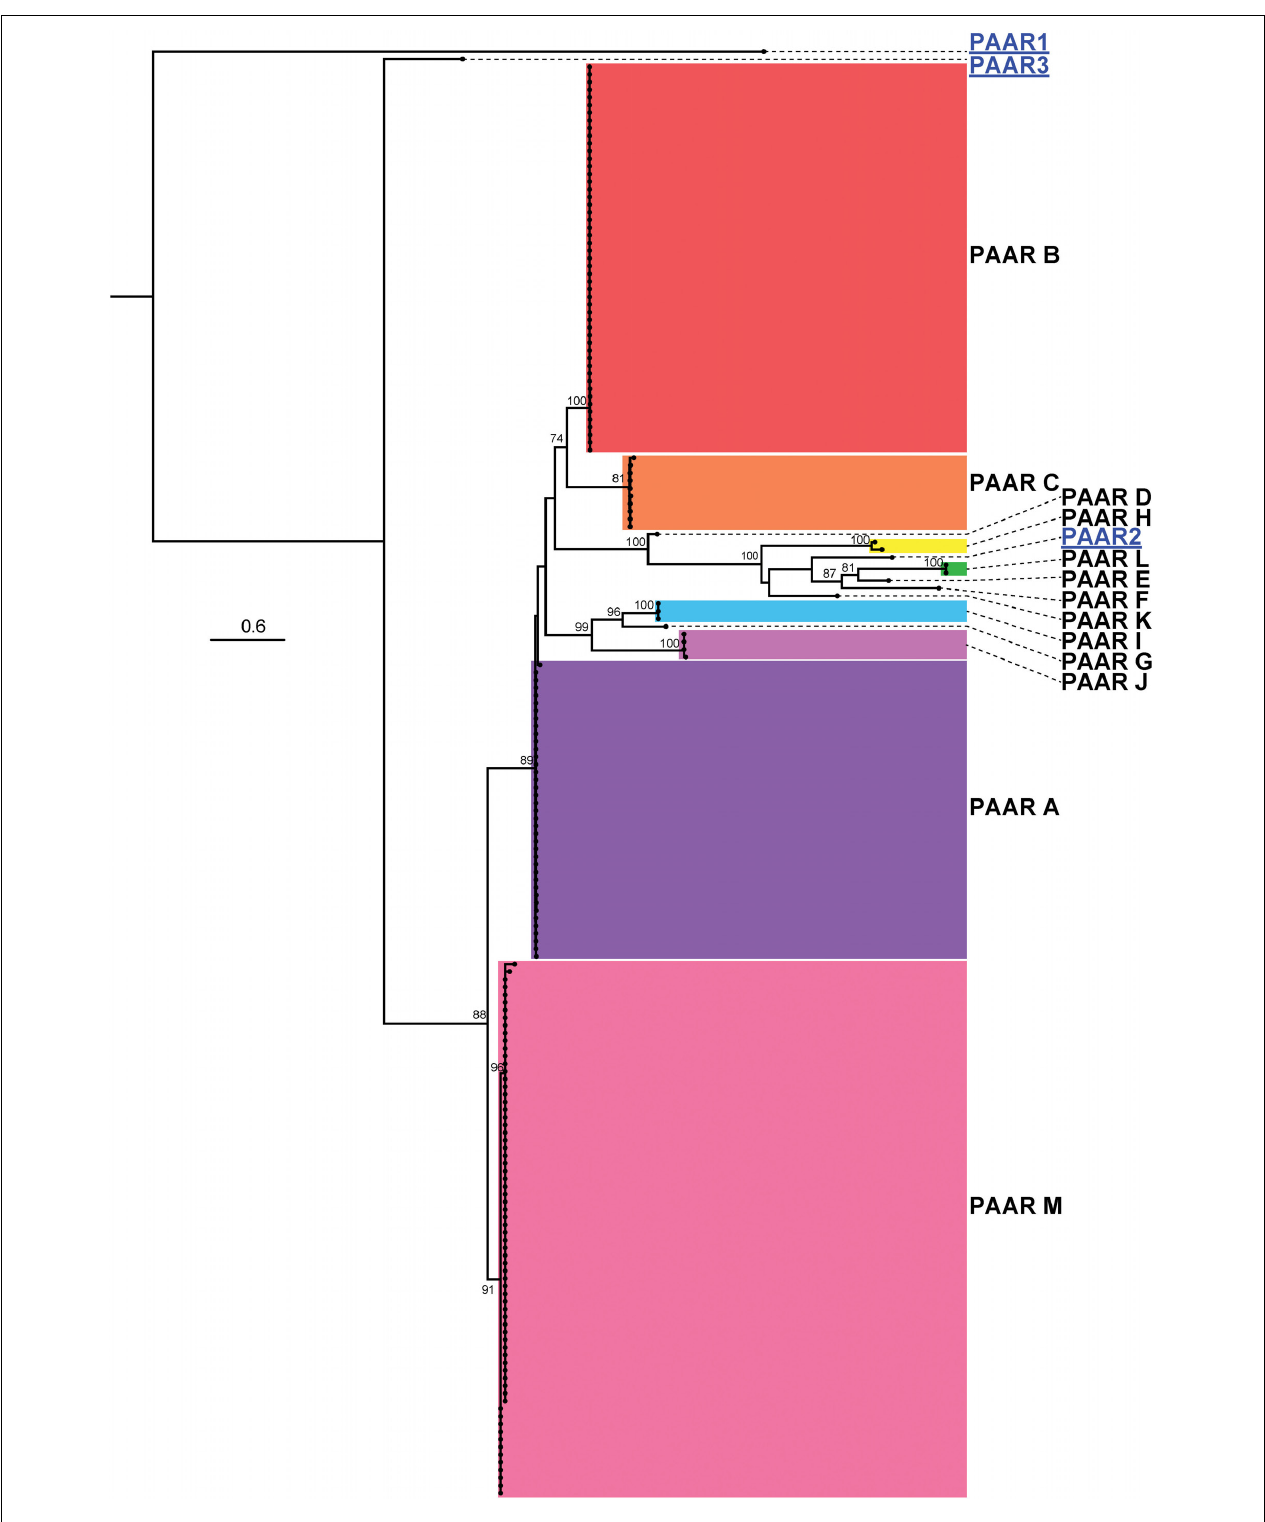
FIGURE 11 | ML phylogenetic tree of A. baumannii PAAR proteins with A. baylyi ADP1 PAAR proteins used for comparison. The tree was generated from PAAR amino acid sequences using the general ‘variable time’ matrix with the discrete Gamma model (VT + G4). The scale bar represents the number of amino acid substitutions. Branch support values ≥ 70 (UFBoot) are shown at all major nodes. Black names represent A. baumannii PAAR proteins, grouped A-M, blue underlined names represent A. baylyi PAAR proteins. Separate areas of the tree have been arbitrarily colored to visually define the groups ( Supplementary Files S3g , S4g